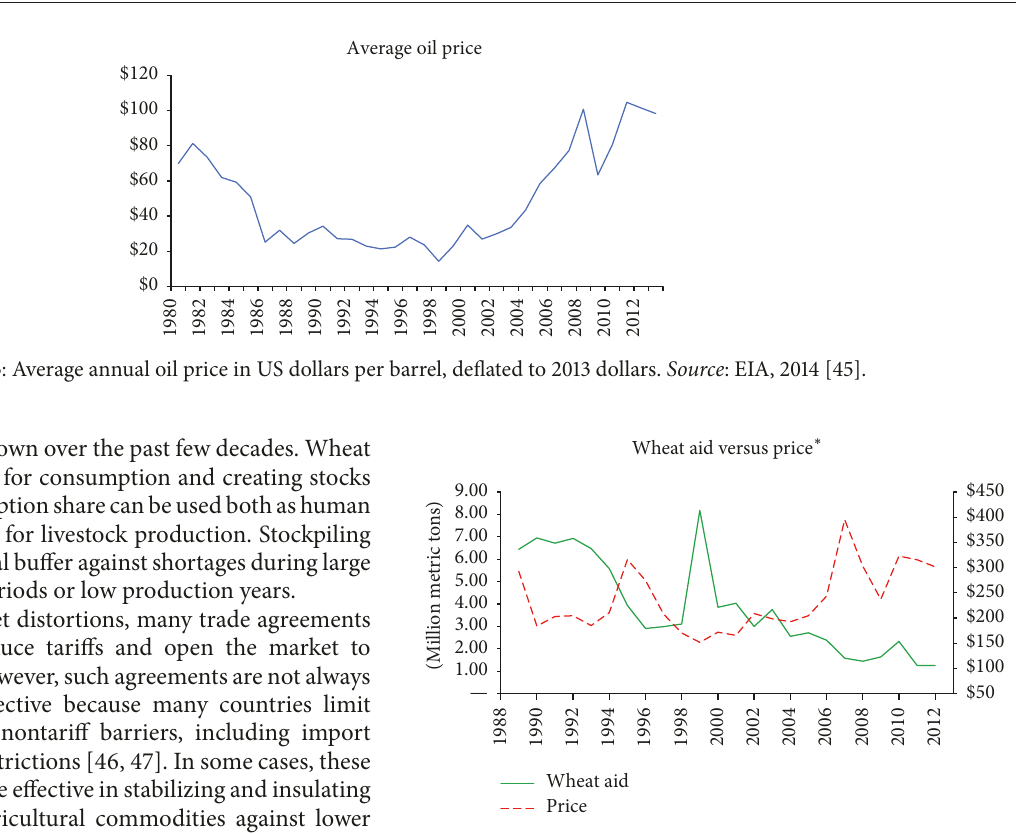
Figure 4: Wheat aid versus wheat price. Source : World Food Program and OECD, 2012 [53]. ∗ Wheat aid is total of wheat and wheat flour provided and wheat prices are deflated in terms of 2013 dollars between 1989 and